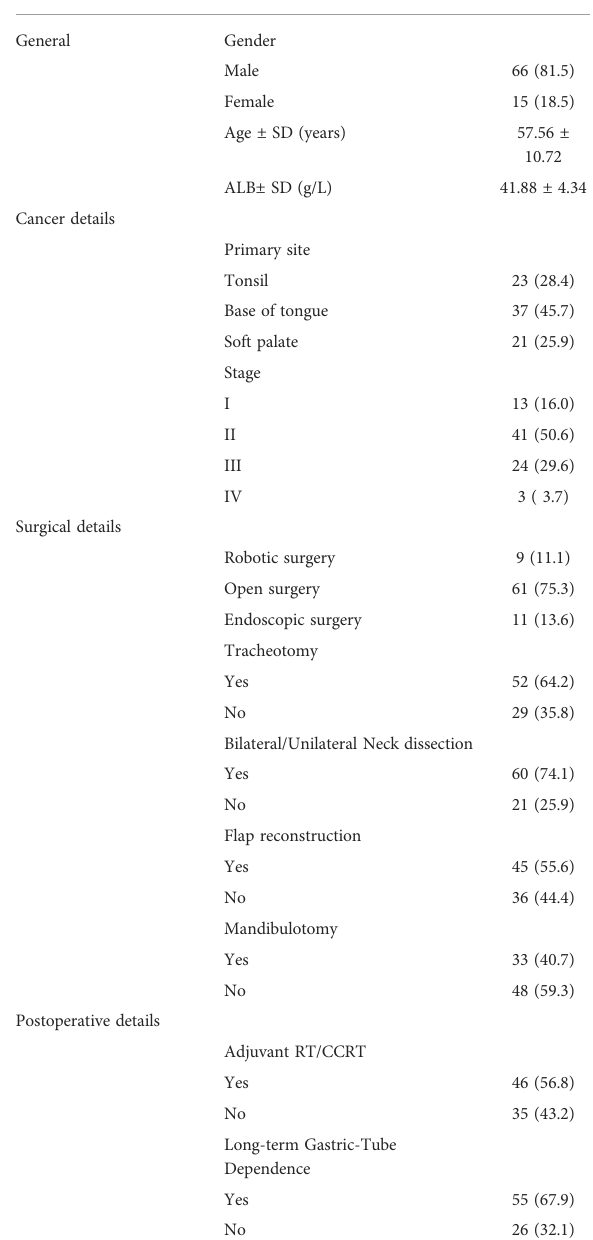
Surgical patients ’ characteristics. All Patients (N =